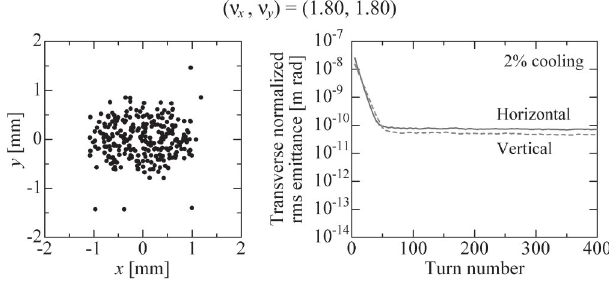
FIG. 4. MD result of an ion beam cooled with a linear fric- tional force. The simulation parameters are the same as those in Fig. 3 except that the transverse bare tunes have been raised to (cid:5) (cid:2) (cid:3) 1 : 80 ; 1 : 80 (cid:5) . The strength of the friction is identical to (cid:3) (cid:4) ; (cid:4) x y that employed in case (b) of Fig. 3. The multishell crystal is no longer formed with these tunes whereas the maintenance condi- tion (2) has been satisfied.